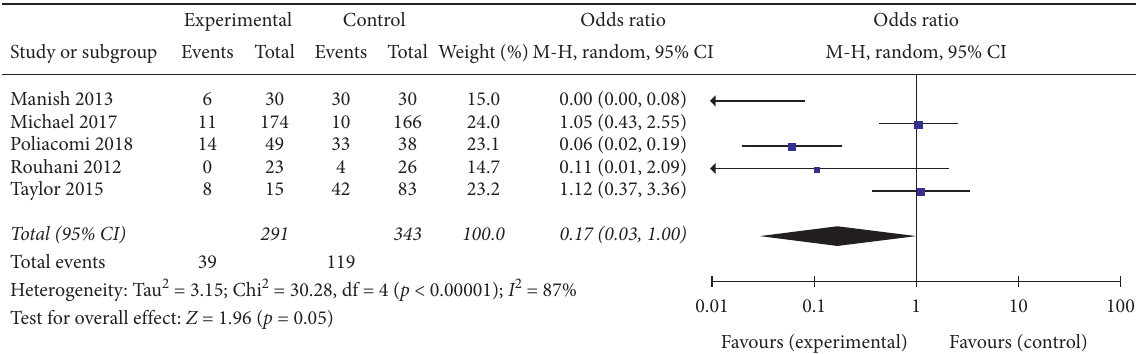
Figure 3: Varus-valgus deformity.